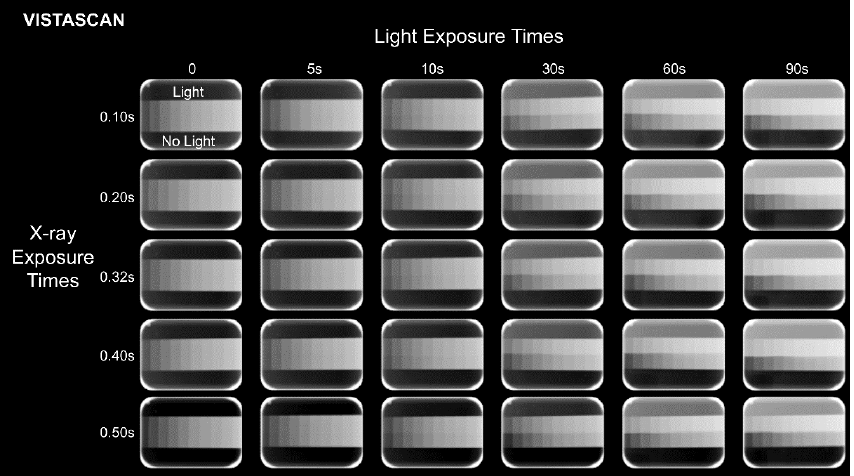
Figure 2. Representative radiographs of each experimental condition obtained using VistaScan. All images are shown using the same display window and level.